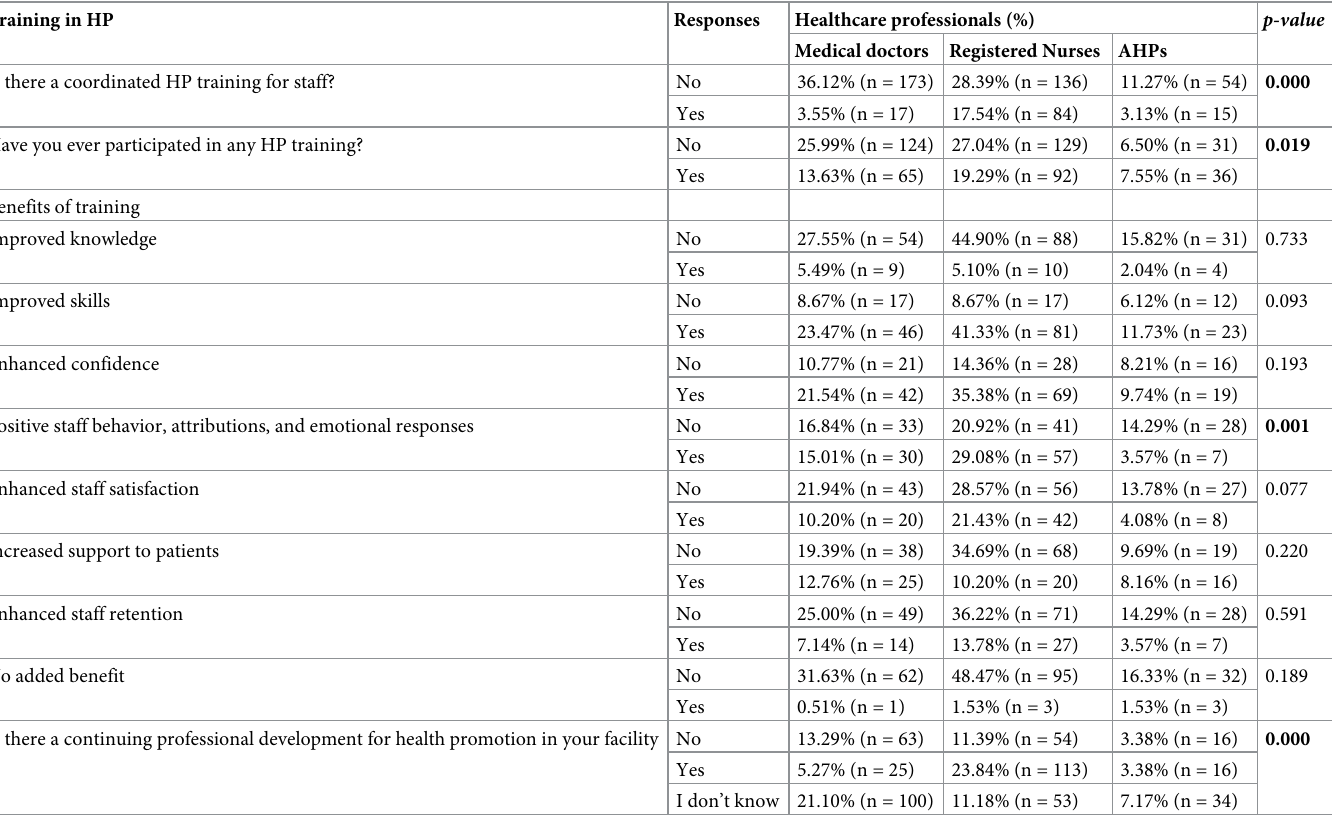
Table 1. Bivariate analysis of training in health promotion and among the different healthcare professional